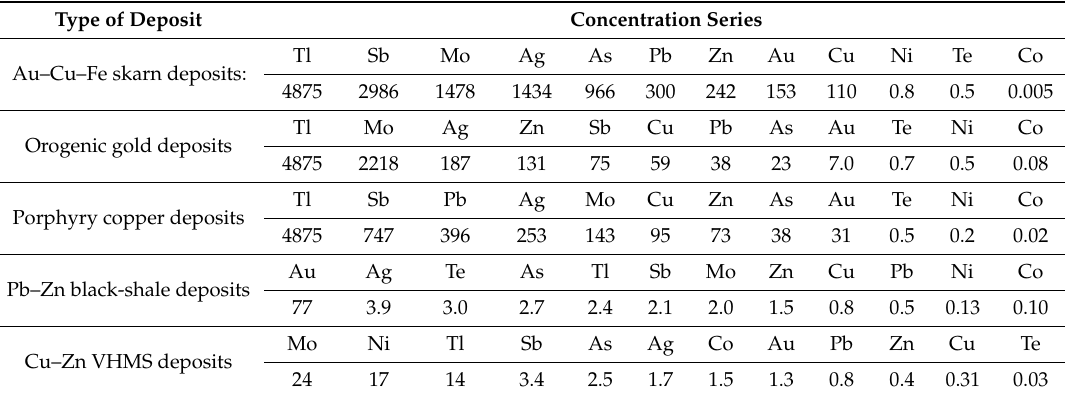
Table 4. Median concentration of chemical elements in framboidal pyrite from the Bazhenov Formation are normalized to pyrite from major ore-formational types of deposits (Bazhenov framboids / ore-deposit pyrite). Concentration